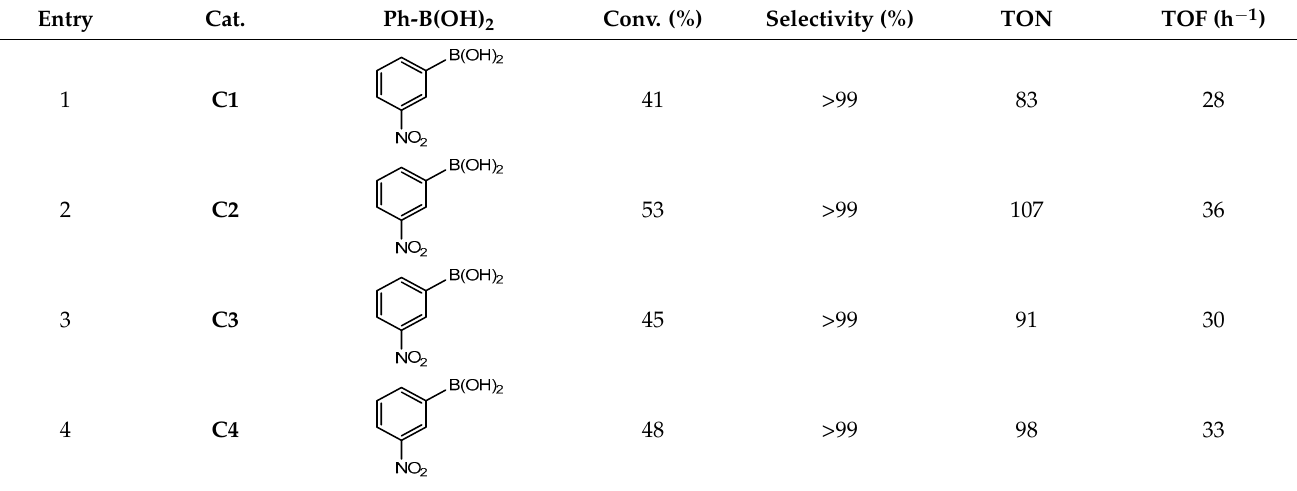
Notes: Reactions carried out in DMF (1.2 mL) with 0.67 mmol of bromobenzene, 1.06 mmol of substituted phenylboronic acid (4 ‐ CHO and 3,5 ‐ diMeO), 1.33 mmol of KOH and 0.5 mol% Pd catalyst loading using n ‐ decane as internal standard and the reaction was allowed to run for 3 h at 150 °C ( C1 – C4 ). Conv. = conversion. Cat. = catalyst. Average error estimate